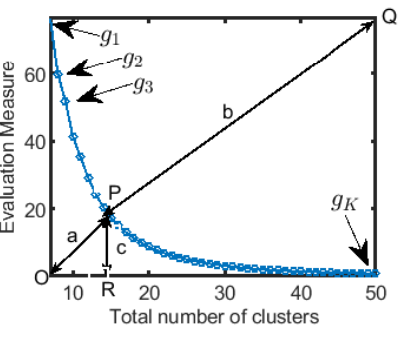
Figure 1. Representation of the parameters of the AutoElbow